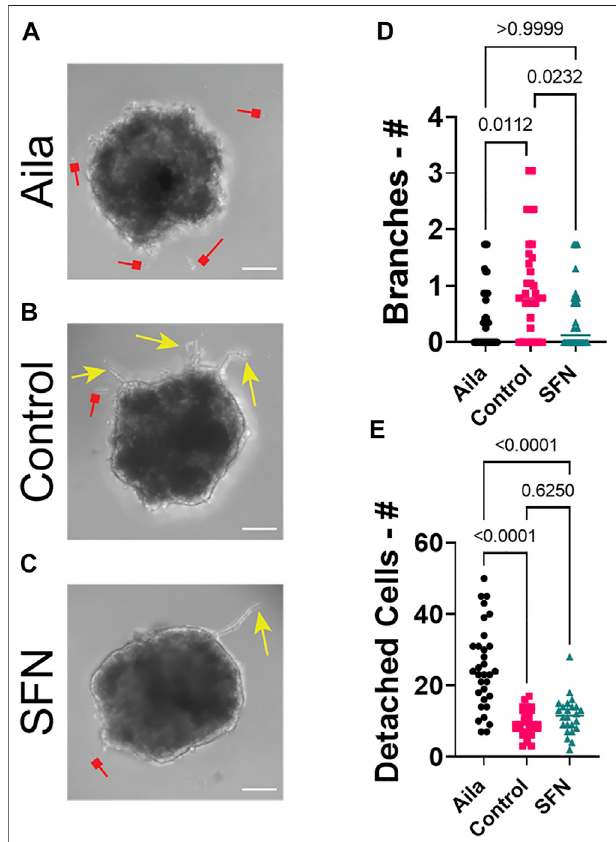
FIGURE 8 | Pharmacological perturbation of 3D invasion. (A – C) Representativeimagesof3DmicrotumorstreatedwithAila,Control,andSFN, respectively. Yellow arrows represent invasive branches protruding from the spheroidsandredarrowsrepresentdetachedcells.Scalebars,100 µm. (D) Normalized number of invasive branches for Aila, Control and SFN. The D ’ AgostinoandPearsontestwasusedtodeterminedatathatarenotnormally distributed (Alia p -value = 0.0165, Control p -value = 0.1437, SFN p -value = 0.0372).ThenonparametricKruskal-Wallis testalongwiththeDunn ’ smultiple comparisons test were used to compare across groups. (E) Average number of detached cells for Aila, Control and SFN, respectively. One-way ANOVA with a post-hoc Tukey ’ s test was used to compare across groups (Aila n = 32 spheroids, Control n = 28 spheroids, SFN n = 24 spheroids). Results are from four experiments performed across different